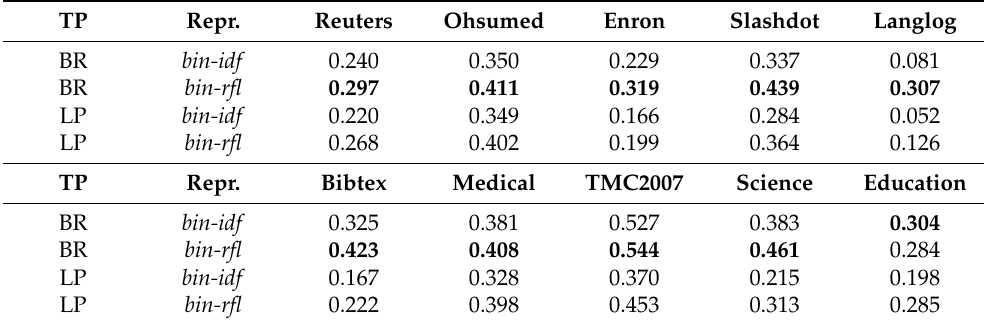
Table 11. Experimental results of different transformations of the problem (PT: BR and LP), and Representations with ANN in terms of macro- F 1 .